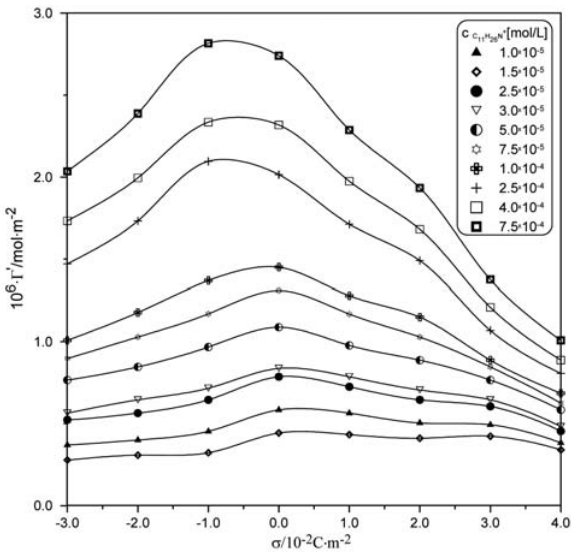
Figure 3. Relative surface excess of C electrode charge and C